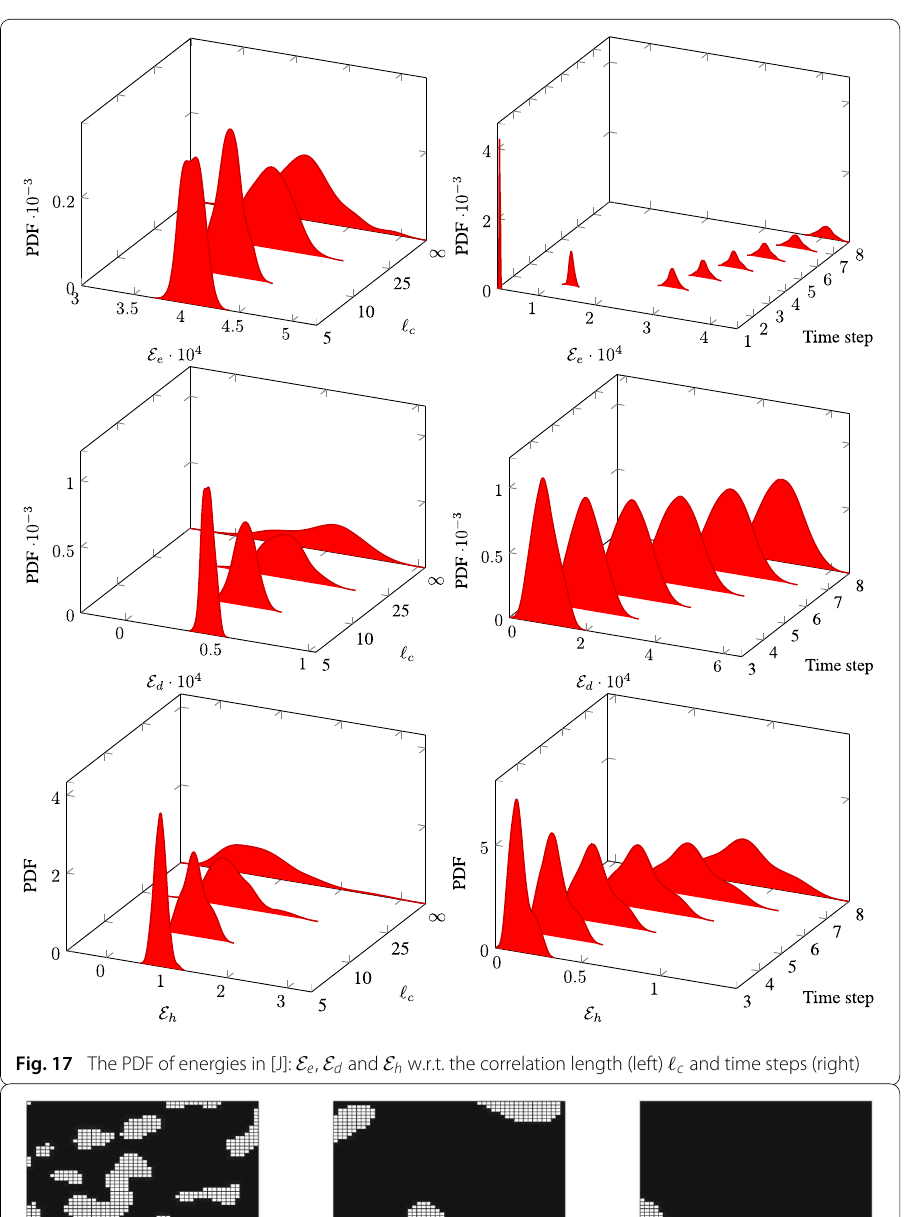
Fig. 18 The presence of damage (elements marked in black) on the meso-scale for c var = 0 . 1 and (cid:23) c = 5 (cid:23) e , = 10 (cid:23) (cid:23) = 25 (cid:23) (cid:23) c e , c e , respectively normal random variables, with the same mean and standard deviation as their meso-scale counterpart. The measurement data are made of three type of averaged data: E e , E d , and E h . Their logarithms are simulated using mixture models and vine copulas, and further